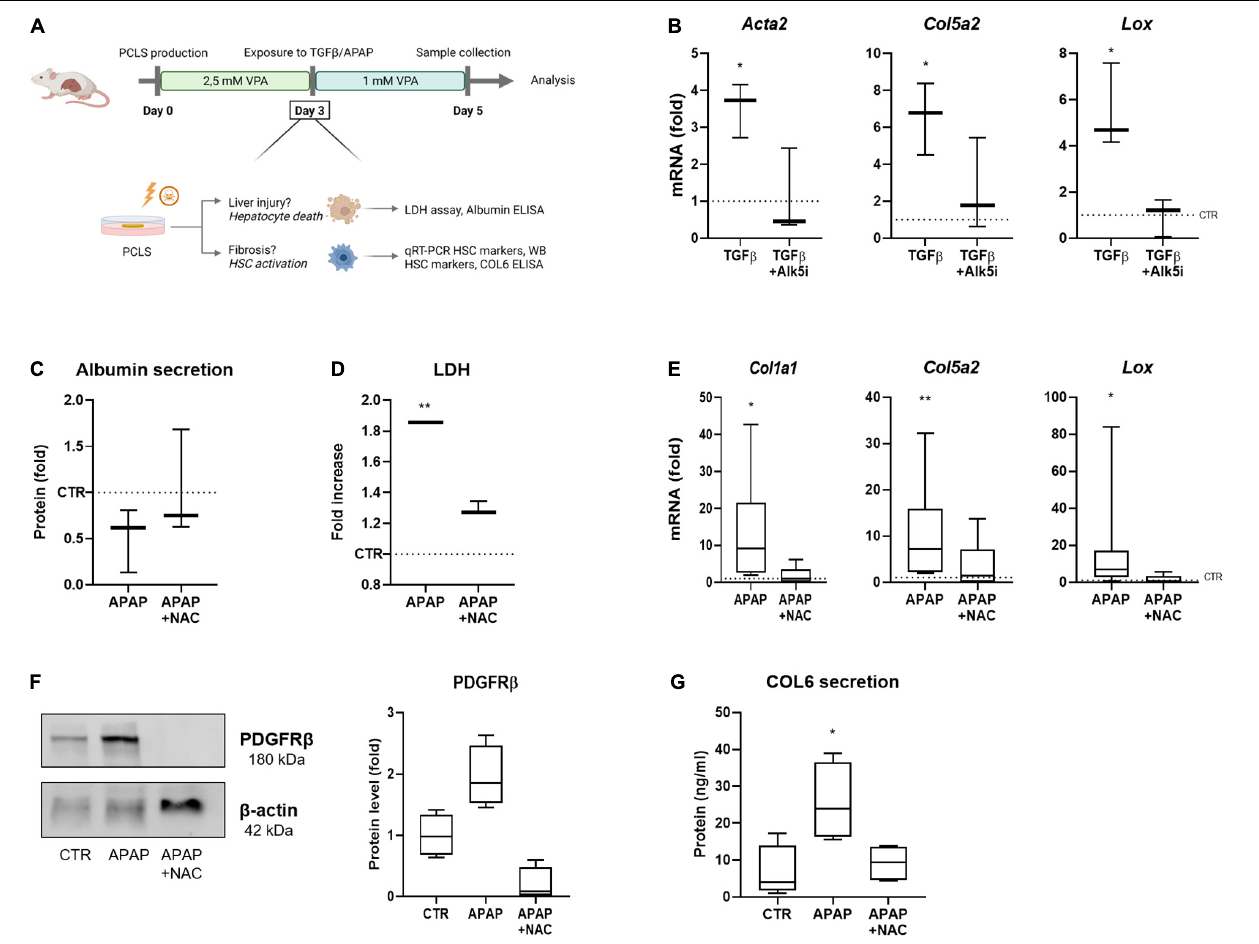
FIGURE 3 | PCLS for in vitro modeling of drug-induced liver injury and fibrosis. (A) General overview of the improved conditions of our mouse PCLS cultures. PCLS are cultured in 2.5 mM VPA between day 0–day 3. From day 3 until day 5, VPA concentration is reduced to 1 mM VPA, while PCLS are exposed to TGF β or APAP. PCLS are collected on day 5 and are analyzed for liver injury or fibrosis. (B) Exposure of PCLS to TGF β induces an increased RNA expression of HSC activation markers ( n = 3). (C) PCLS exposed to APAP show a decreased albumin secretion ( n = 3), (D) an increase in LDH leakage ( n = 3), (E) increased RNA expression of HSC activation markers ( n = 9), (F) increased protein expression of HSC marker PDGFR β ( n = 4), and (G) an increased secretion of collagen 6 in the culture medium ( n = 4). The dotted line represents the corresponding control. * p ≤ 0.05, ** p ≤